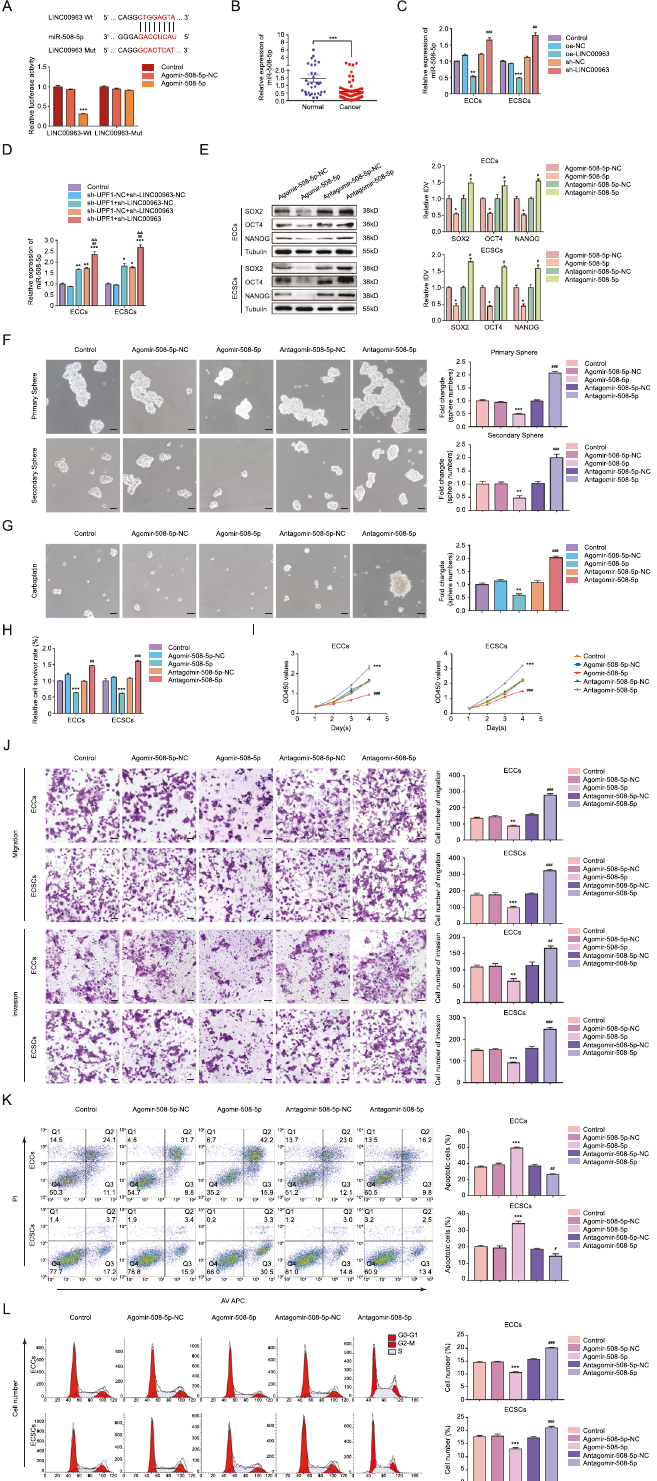
and the proportion was increased in the sh-UPF1 group (Fig. 2F). UPF1 overexpression improved the fraction of ECSCs in G2 – M phase, and UPF1 knockdown decreased the cell number (Fig. 2G). Similar but less pronounced results were observed in ECCs. Brie fl